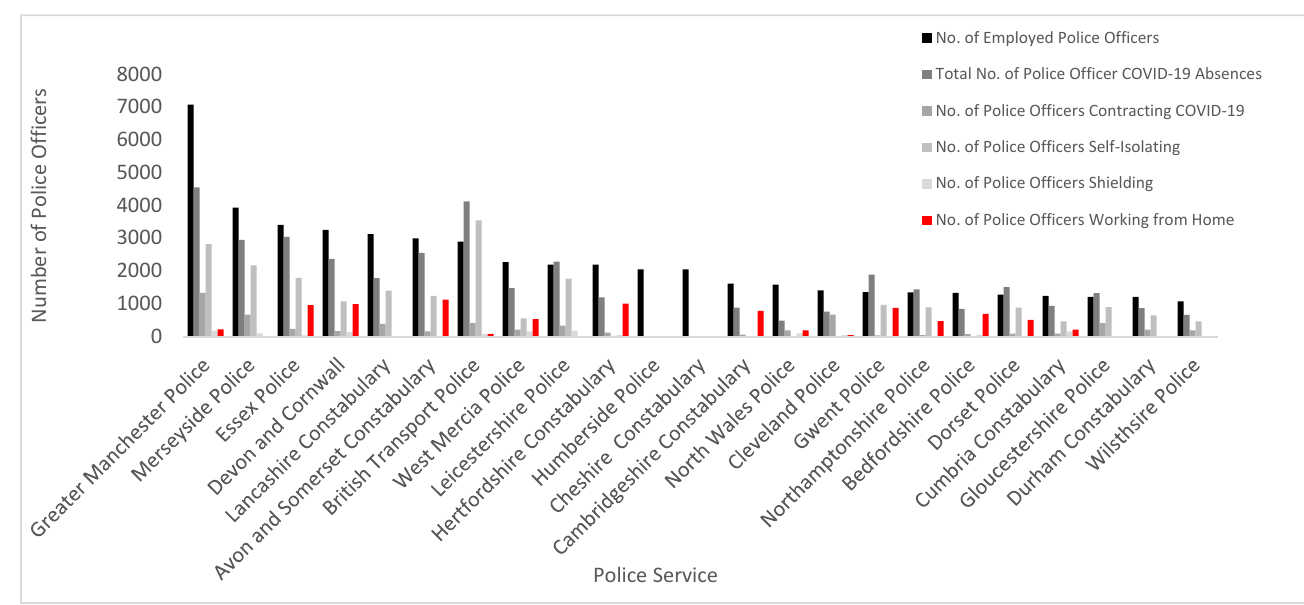
Figure 2. Overall impact of COVID-19 on available police officer capacity by police service.